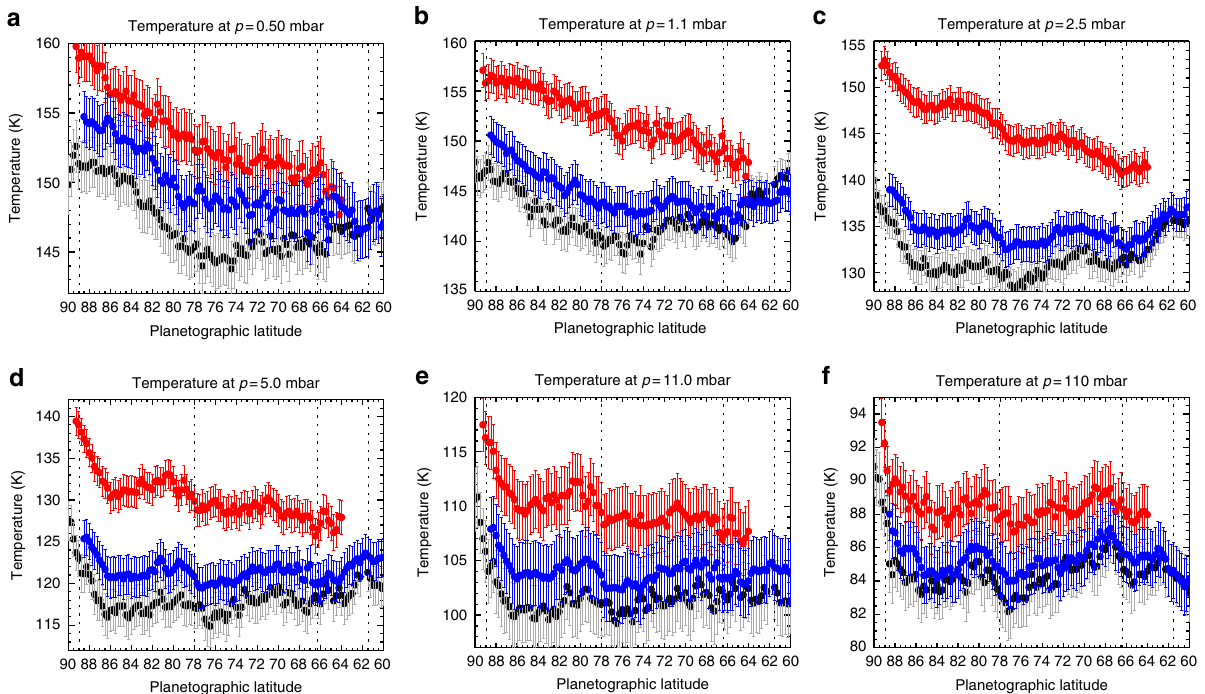
Fig. 8 Zonal-mean north polar temperatures for three REGMAP data sets showing the warming of the polar stratosphere. Temperatures are displayed at six pressure levels: a 0.5 mbar, b 1.1 mbar, c 2.5 mbar, d 5.0 mbar, e 11 mbar, and f 110 mbar. Three dates are included in each panel: August 17 2013 (black, REGMAP 196 – 001), June 25 2014 (blue, REGMAP 205 – 001), and February 12 2017 (red, REGMAP 261 – 003). Vertical dotted lines show the locations of prograde jet peaks 9 for comparison with the meridional temperature gradients. Error bars represent the formal retrieval uncertainty. Note that the June 2014 data set utilised 15-cm − 1 resolution spectra, whereas the 2013 and 2017 data sets are better constrained by 2.5-cm − 1 resolution